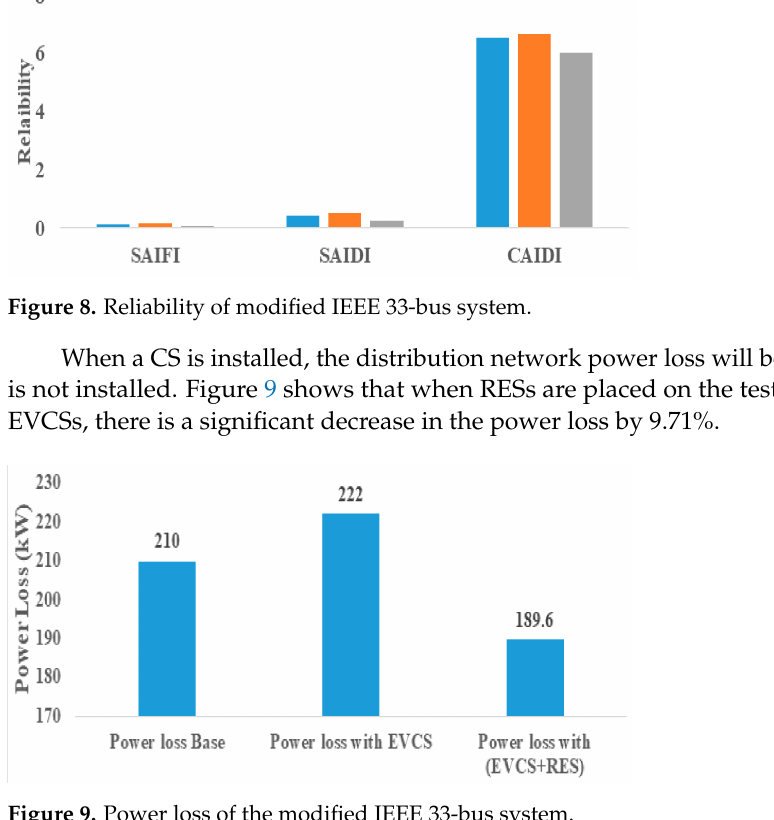
Figure 9. Power loss of the modified IEEE 33-bus